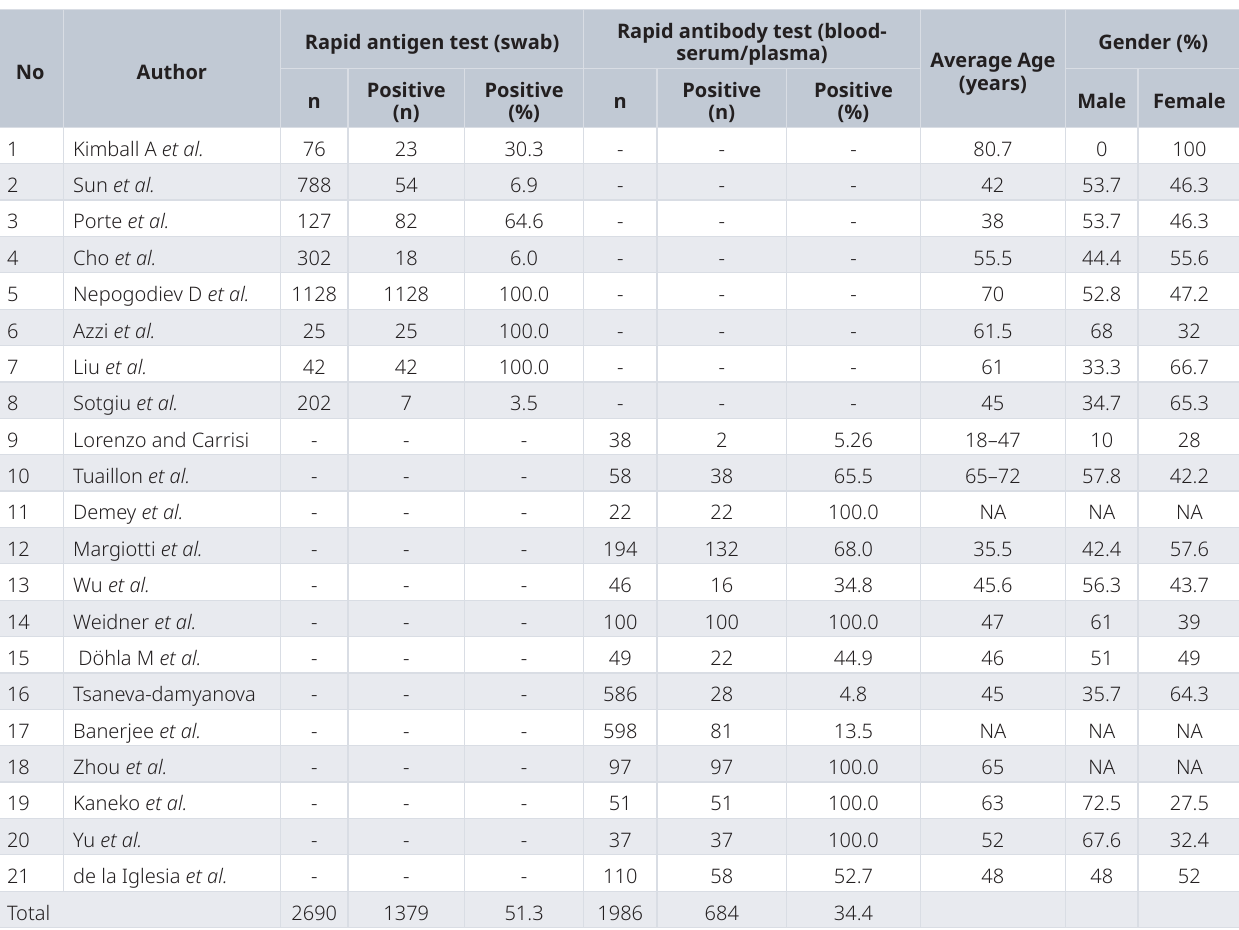
Table 3. Screening tests used to detect